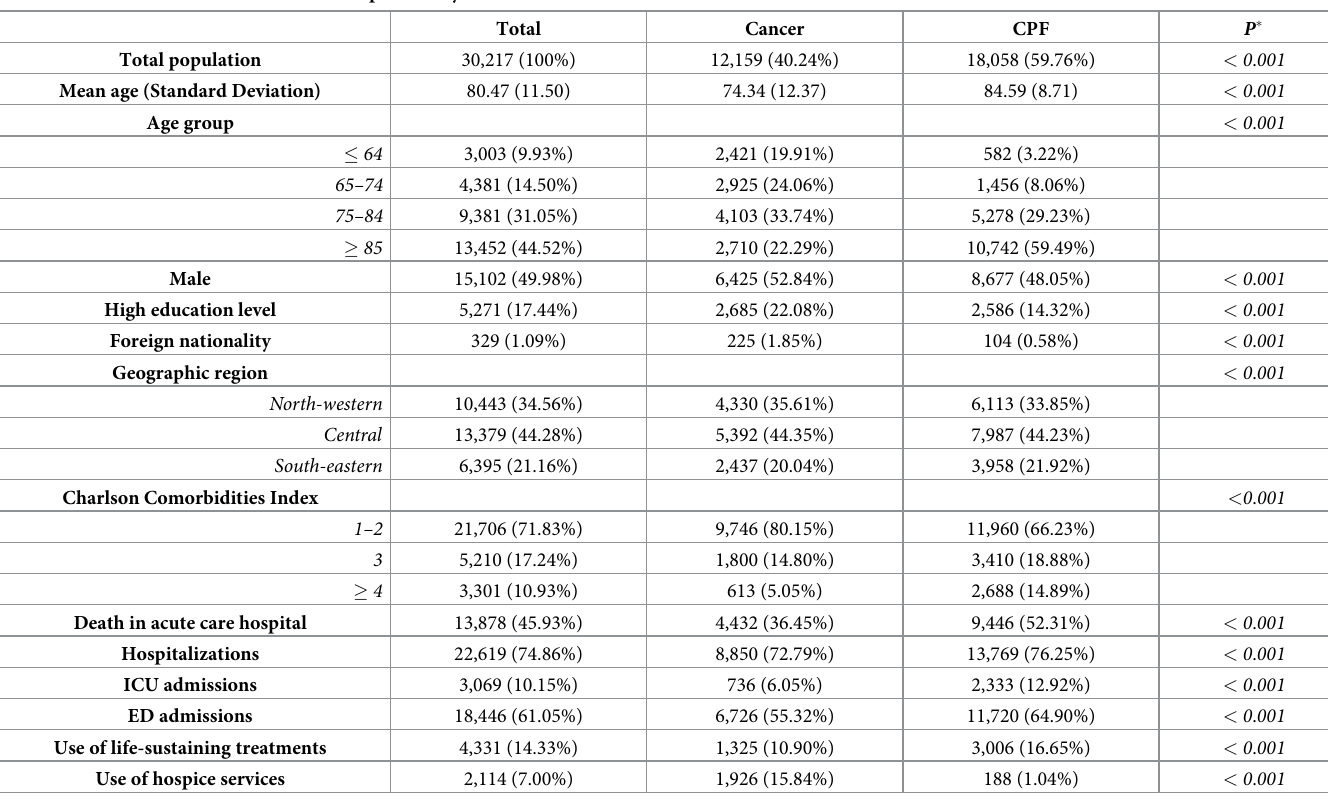
Table 2. Characteristics of cancer and cardiopulmonary failure